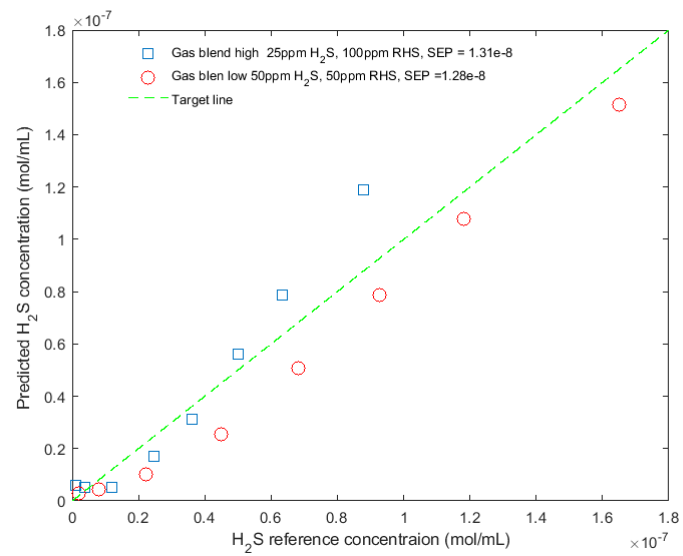
Figure 10. Prediction vs. reference of H 2 S concentration of two mixture samples (H 2 S and CH 3 SH mixture) at eight pressure setpoints using the MOC prototype sensor. Table 1. Summary of MOE performance .